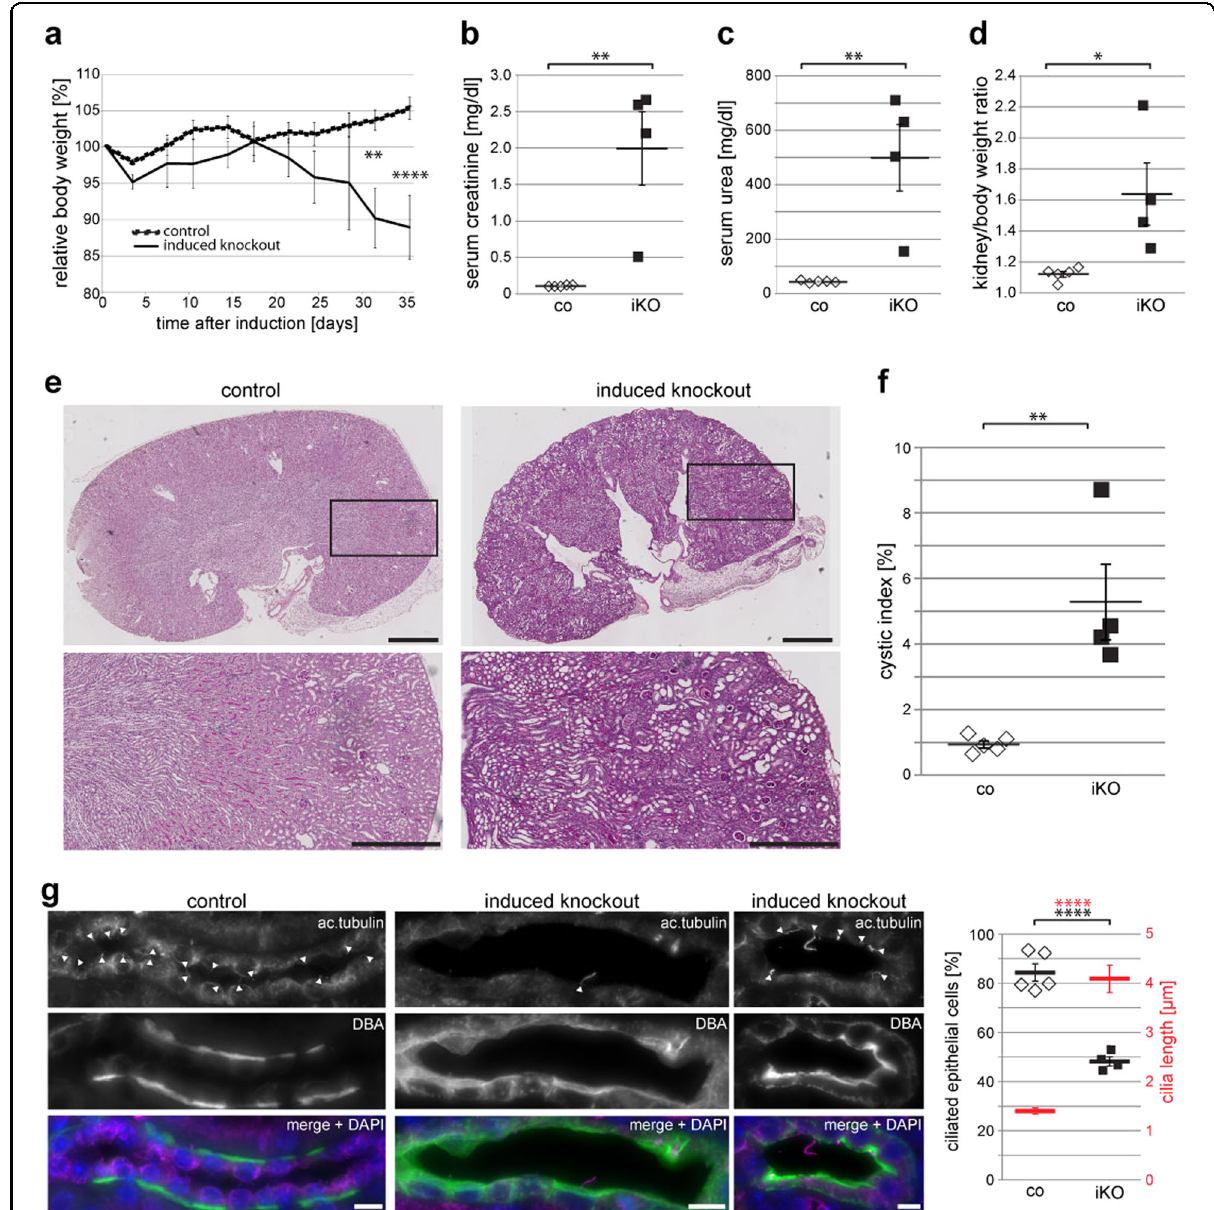
Fig. 3 Ruvbl1 is required for maintenance of kidney function and tubular architecture. a Loss of Ruvbl1 in adult mice was achieved by using a tamoxifen-inducible Ksp:Cre mouse line. Induced loss of tubular Ruvbl1 ( n = 4) resulted in signi fi cant body weight loss at 32 days (** p < 0.01) and at 35 days (**** p < 0.0001) after induction, while control mice consistently gained weight ( n = 5). Repeated measures two-way ANOVA with Bonferroni- corrected post hoc analyses (F(10,70) = 5.807, p < 0.0001). Mean body weight ± SEM. b , c Induced loss of tubular Ruvbl1 (iKO) resulted in increased serum creatinine (t(7) = 4.255, ** p < 0.01) ( b ) and serum urea (t(7) = 4.232, ** p < 0.01) ( c ) levels compared with controls (co). Mean values at sacri fi ce ± SEM. d – f Induced loss of tubular Ruvbl1 (iKO) resulted in a signi fi cantly increased kidney-to-body-weight ratio (t(7) = 2.905, * p < 0.05) ( d ), dilated tubules as shown in the histological PAS staining ( e ), and a signi fi cantly increased cystic index (t(7) = 4.255, ** p < 0.01) ( f ) compared with controls. Scale bars, e : 1 mm (upper panel) and 500 µm (lower panel). g Induced loss of tubular Ruvbl1 (induced KO) resulted in signi fi cantly fewer and longer ciliated cells (magenta, arrowheads pointing to cilia) and an altered apico-basal localization of the collecting duct marker DBA (green) compared with controls. The graph on the right depicts the number of ciliated epithelial cells in black (t(7) = 8.435, **** p < 0.0001) and cilia length in red (t(143) = 11.87, **** p < 0.0001). Z-stacks: 1 µm. Scale bars: 10